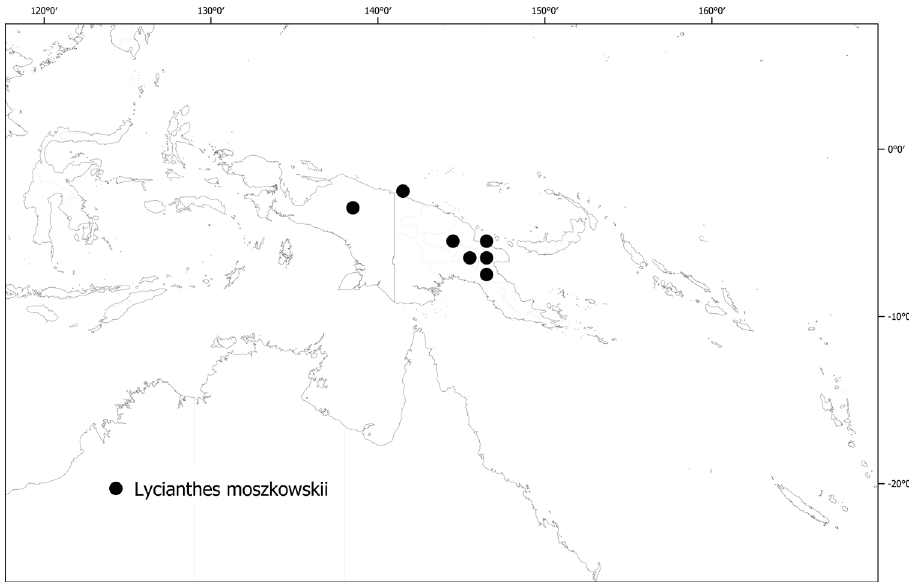
Figure 33. Distribution of Lycianthes